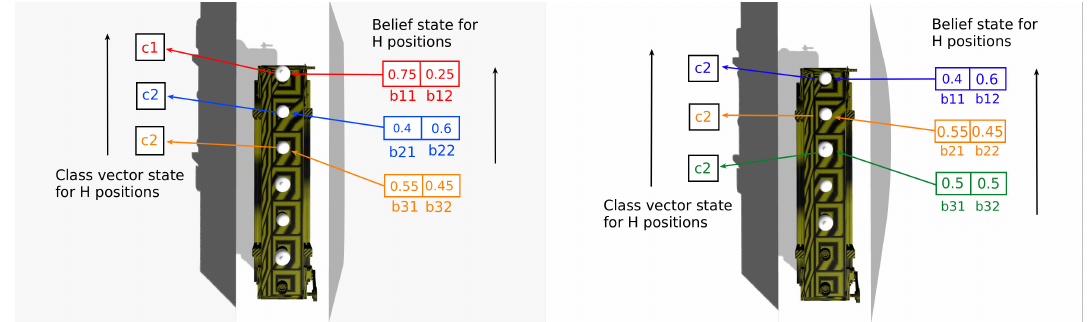
Figure 1. Belief state and class vector state before propagation ( left ) and after propagation ( right ), shown for an top view of the conveyor belt. Beliefs and classes are maintained maintained at each position, and whenever a decision is taken and the belt moves, these values are propagated in the direction indicated by the